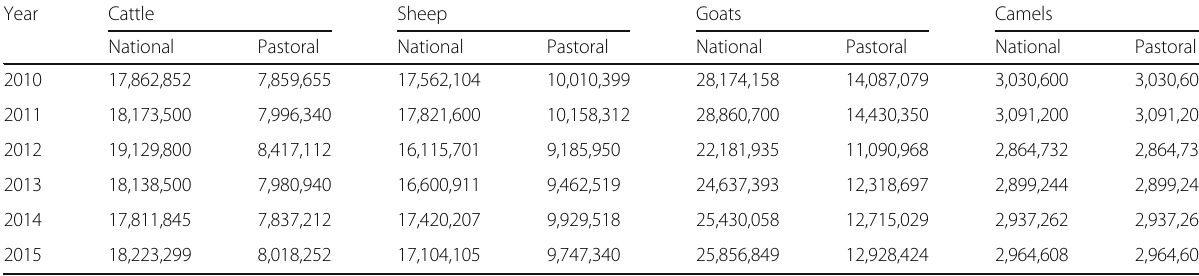
Table 1 National livestock population in relation to pastoral herd in Kenya, 2010 – 2015